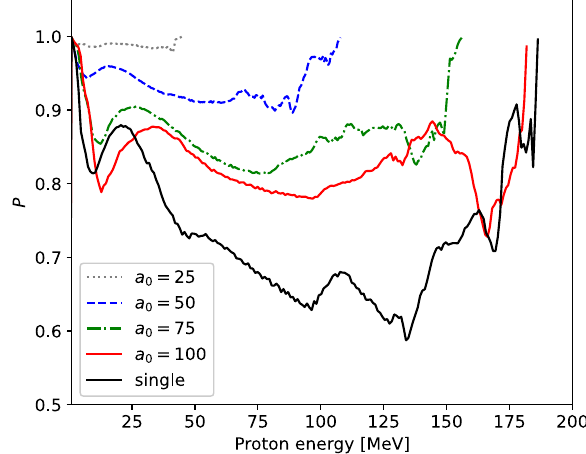
FIG. 5. Polarization spectra for the different simulations in the whole simulation box. The minimum polarization is only reached for very high